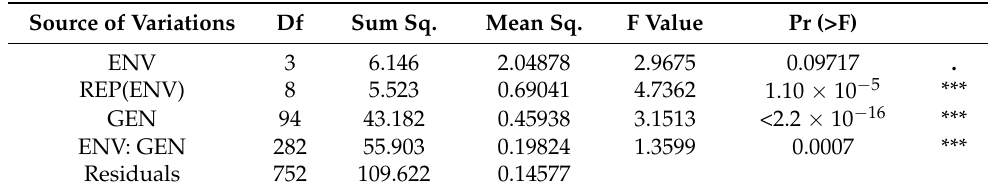
Table 4. Analysis of variance for yield data obtained from BGN trials conducted in Ibadan and Ikenne in 2018 and 2019 (environments constitute year–location combinations). Source of Variations Df Sum Sq. Mean Sq. F Value Pr (>F) ENV 3 6.146 2.04878 2.9675 0.09717 . REP(ENV) 8 5.523 0.69041 4.7362 1.10 × 10 − 5 *** GEN 94 43.182 0.45938 3.1513 <2.2 × 10 − 16 *** ENV: GEN 282 55.903 0.19824 1.3599 0.0007 *** Residuals 752 109.622